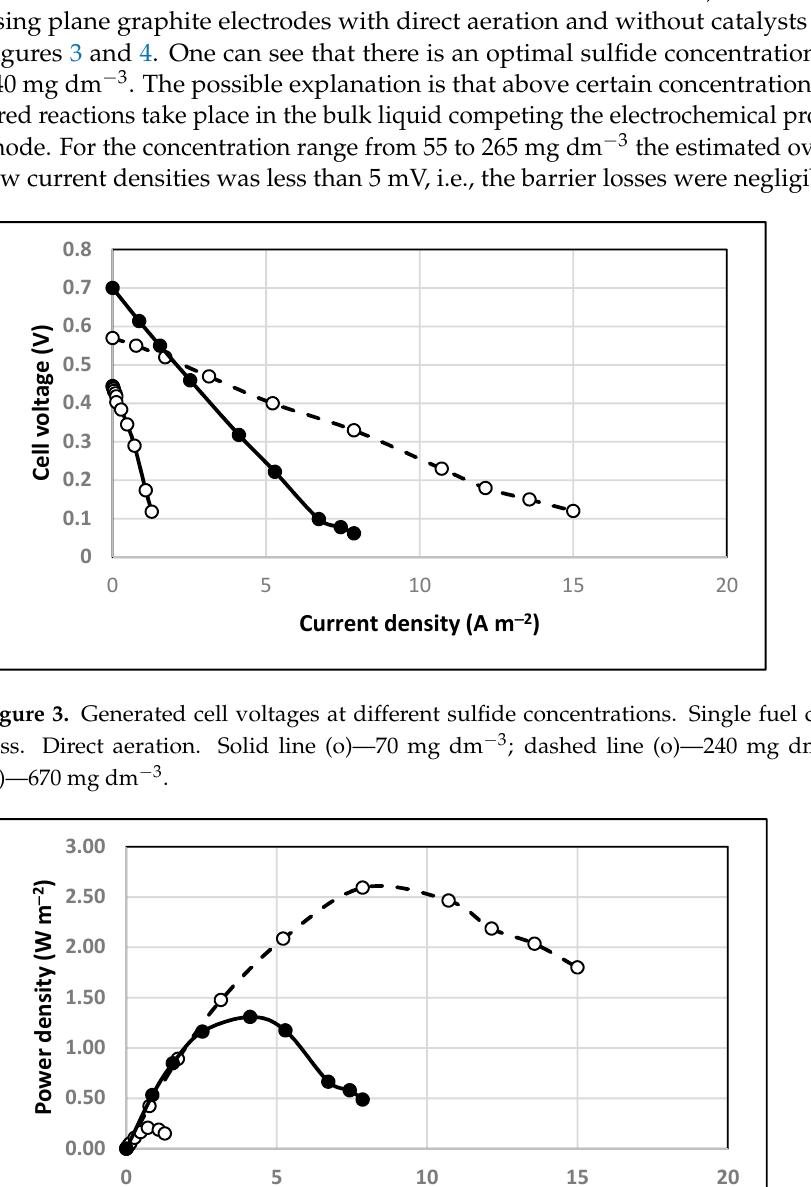
Figure 4. Power densities generated in the fuel cell at different sulfide concentrations. Single fuel cell. Batch process. Direct aeration. Solid line (o)—70 mg dm − 3 ; dashed line (o)—240 mg dm − 3 ; solid line ( • )—670 mg dm − 3 .